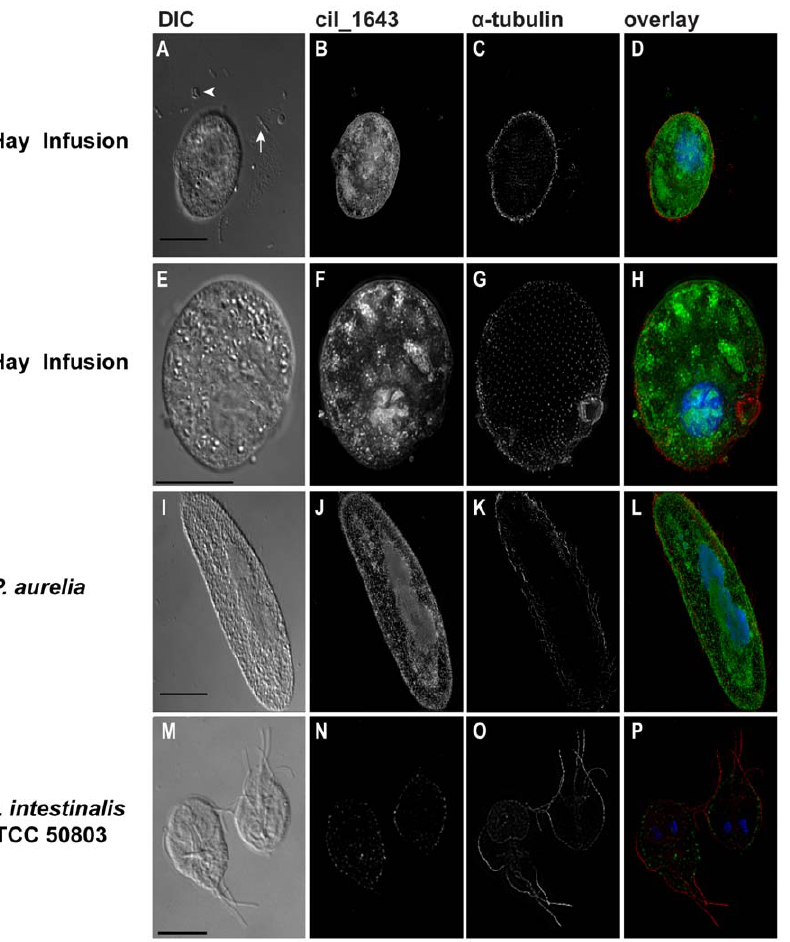
Figure 2. ImmunoFISH links ciliate-specific phylotypes with their cytoskeletal morphologies in the hay infusion enrichment. Ciliate positive control P. aurelia (I–L) and the diplomonad negative control G. intestinali s ATCC 50803 (M–P) are also shown. Fixed samples were hybridized with the ciliate-specific ssu rRNA probe (B, F, J, N) and overlaid with an anti- a -tubulin antibody to stain cytoskeletal features of each cell (C, G, K, O). The image overlays (also see 3D stack in Video S2) show the ciliate-specific ssu rRNA probe (green), anti- a -tubulin antibody (red), and DAPI nucleic acid stain (blue) (D, H, L, P). The tailed arrow marks a bacterium, and the arrowhead marks an amoeba. Scale bars=25 m m with the exception of the positive control G. intestinalis ATCC 50803 (M) with the scale bar=10 m